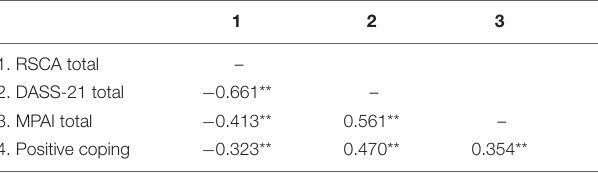
TABLE 3 | Correlation analysis of study variables.